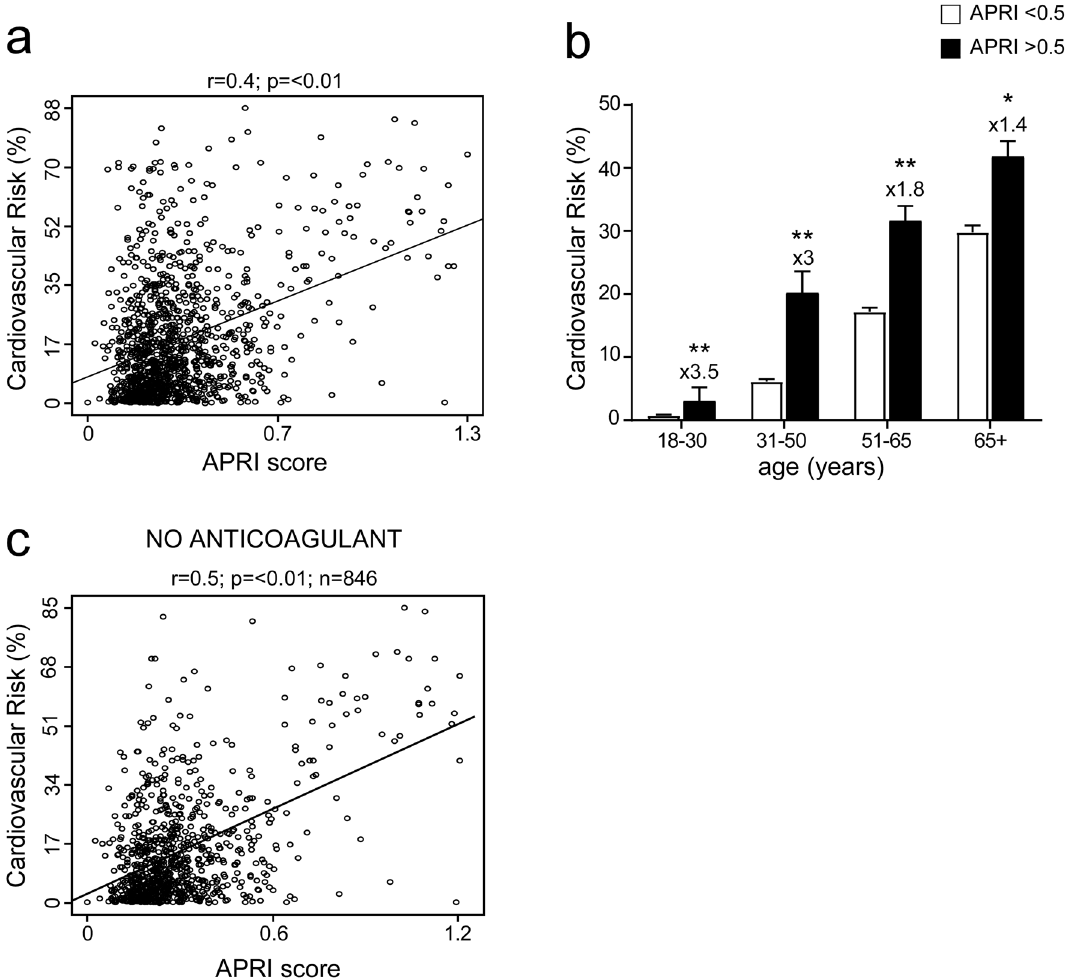
Figure 3. Correlation between APRI score and cardiovascular risk in general population and classification by age. ( a ) Correlation analysis of APRI and cardiovascular risk (CVR) in the entire study population. ( b ) Classification of entire study population in age ranges; subjects were divided by APRI levels with a cut-off of 0.5 to identify elevated APRI. Data is presented as mean ± SEM. Statistical significance was assessed by Student T-test (*p < 0.05, **p < 0.01). Multipliers are shown to identify difference in CVR in subjects with APRI > 0.5 compared to subjects with APRI < 0.5 of the same age. ( c ) Correlation of APRI and CVR after removal of patients ongoing anticoagulant or antiplatelet